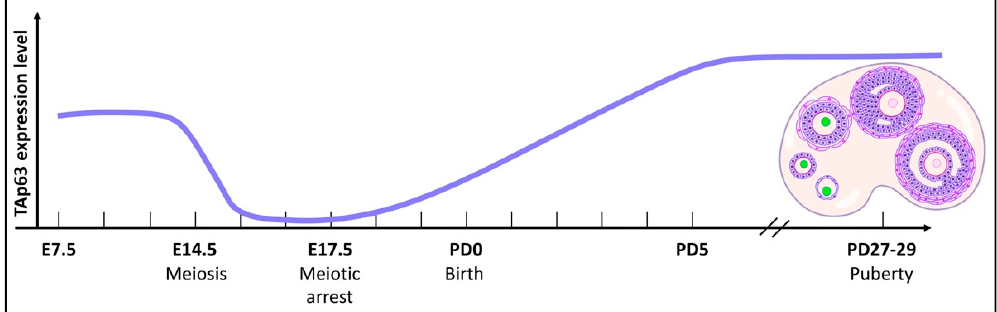
Figure 2. The TAp63 expression pattern. The graphical plot of TAp63 expression in primordial germ cells during embryonic development and in oocytes during folliculogenesis in the mouse. The green color indicates the expression of TAp63 in the oocyte nucleus. This is recapitulated based on Kurita et al . , Suh et al . , and Jurita et al.